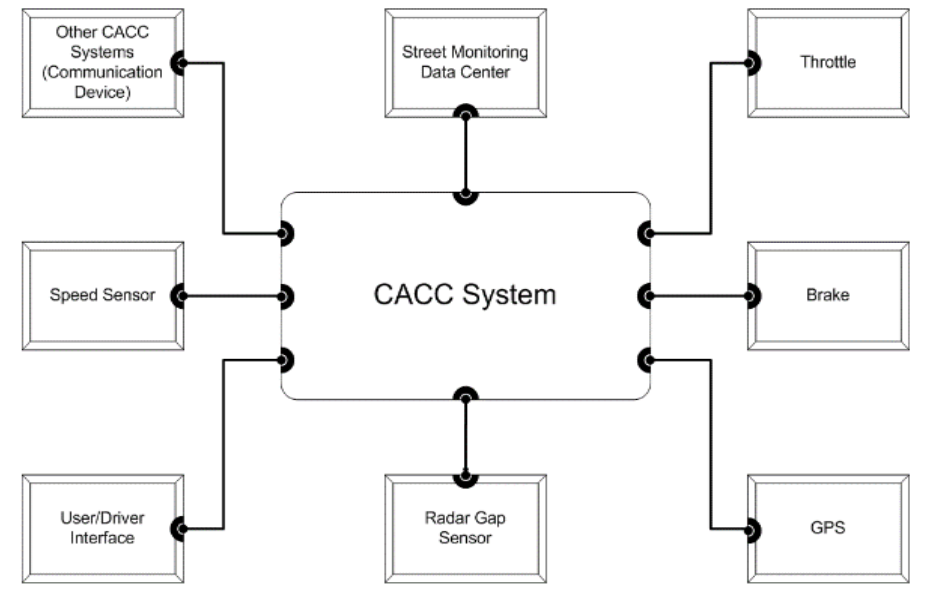
Figure 7. Context diagram of the CACC design.